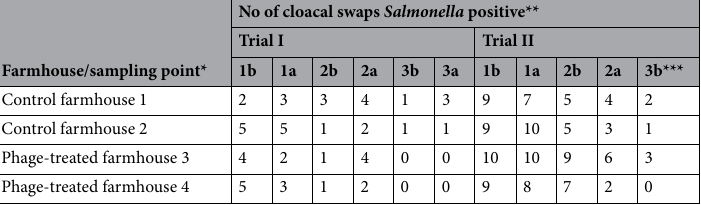
Table 1. Salmonella reduction throughout the production cycle of trials 1 and 2 for farmhouses treated with and without SalmoFree. Data modified from Clavijo et al . 32 . *Nomenclature of the sampling point corresponds to the number of dose (1–3) followed by a letter indicating whether it was taken a day before (b) or after (a) the corresponding dose. **Total number of swaps sampled: n = 5 in Trial 1 and n = 10 in Trial 2. ***Data for samples taken after dose 3 (3a) in Trial 2 are not shown due to the accidental loss of the samples.